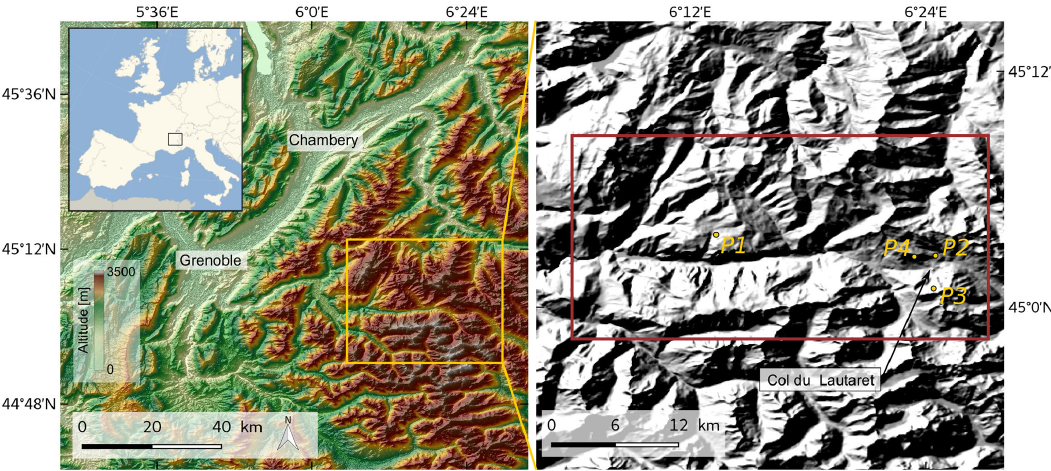
Figure 3. Location of the Col du Lautaret experimental site. The extent used for the validation of the model is outlined in red, over the hillshade product generated from and draped over the 30m ASTER DEM. The four individual sites are marked as yellow dots. (Europe map